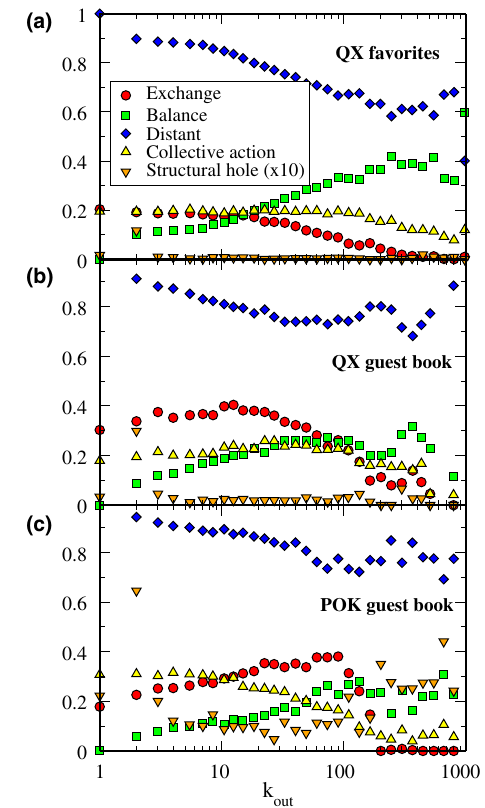
FIG. 5. Fraction of the appearance of a tendency as a function of the adding member’s list size, at the time of addition. Qualitatively, all three data sets are in agreement with each other. The small quantitative differences may be due to the different means of interaction and/or the design of each